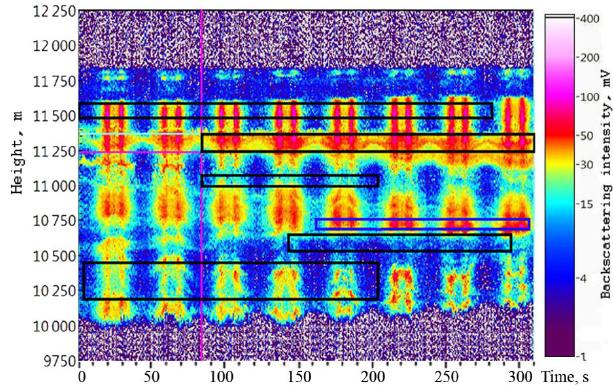
Figure 10. Selection of cloud sections for further processing. Recorded on 2 June 2018 at 12:00–12:05LT. Rectangles highlight areas which have a pronounced dependence on the tilt angle, and there is no signal overflow when the lidar is oriented to